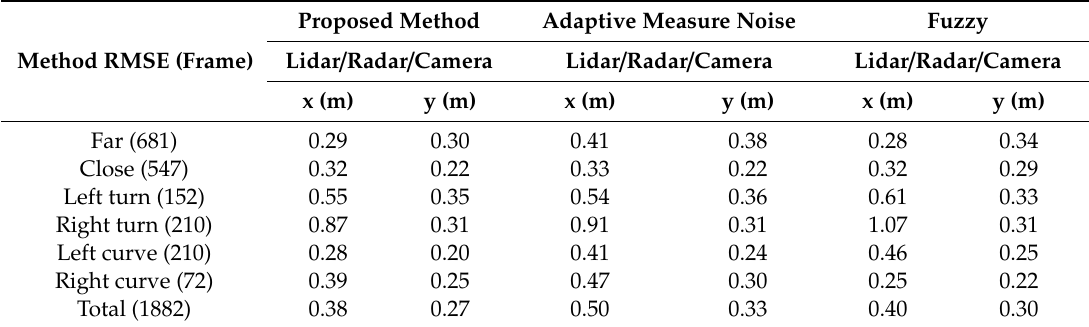
Table 3. Comparison of the results of the proposed method with other sensor fusion